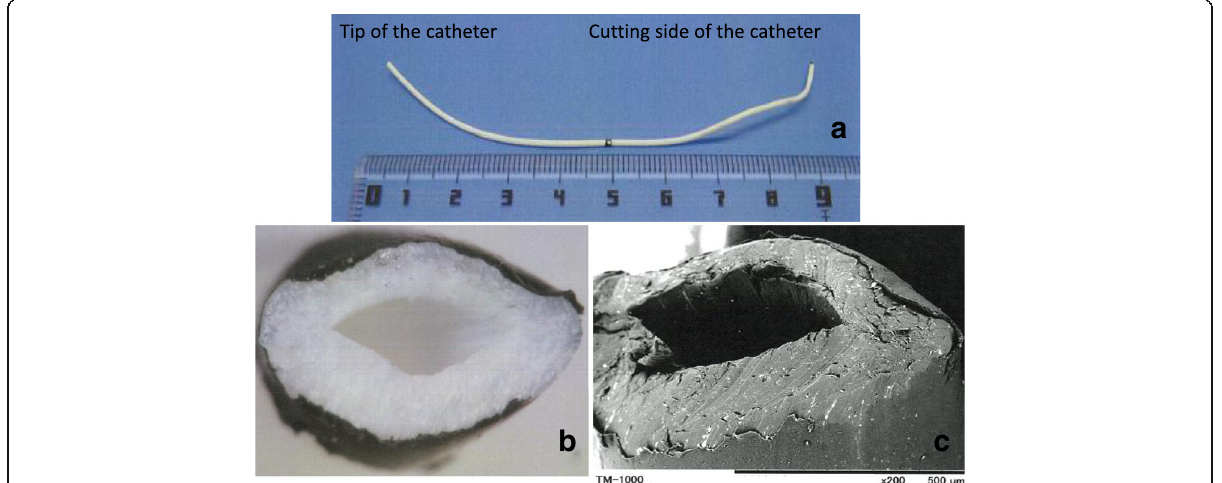
Fig. 3 Photograph and transmission electron micrograph of the paravertebral catheter fragment. The catheter was cut 100 mm from the tip ( a ). The catheter was severed without stretching, and the cut surface is slightly crushed, and smooth, on photomacrography ( b ) and transmission electron micrography ( c